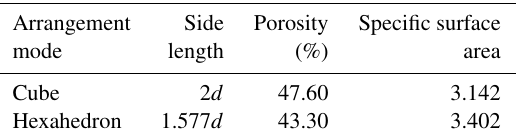
Table 6. Characteristic values of the pore structure for different ar- rangements with the same particle